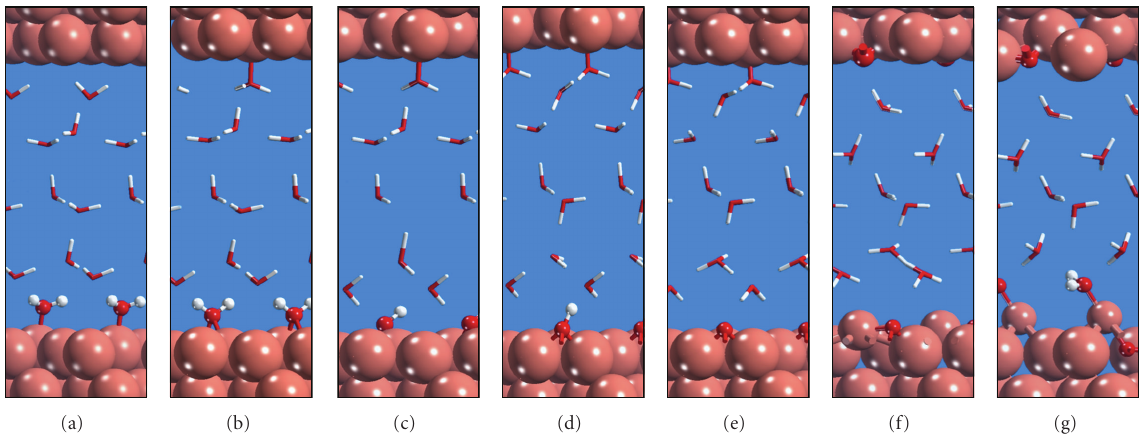
Figure 5: Charge-induced reaction sequence for the activation and migration of H 2 O (a)–(c), OH (c)–(e) and O (e)–(g) on Cu(111), followed by oxidation of Cu (f)-(g) e ff ected by adsorbed oxygen